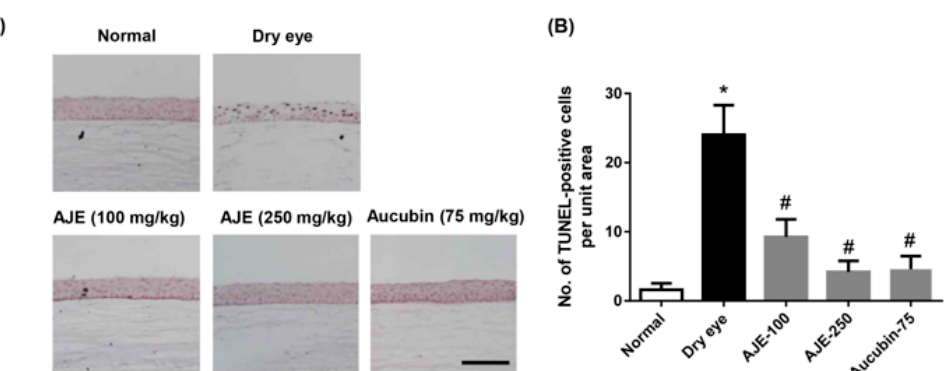
Figure 6. Effects of AJE and aucubin on the number of apoptotic cells in ocular surface of dry eye rats. ( A ) Apoptotic cells were stained by TUNEL assay. Scale bars = 100 µ m. ( B ) TUNEL-positive cells were counted in the unit area. The values in bar graph represent the mean ± SE. n = 7. * p < 0.05 vs. normal rat, # p < 0.05 vs. vehicle treated dry eye rat.